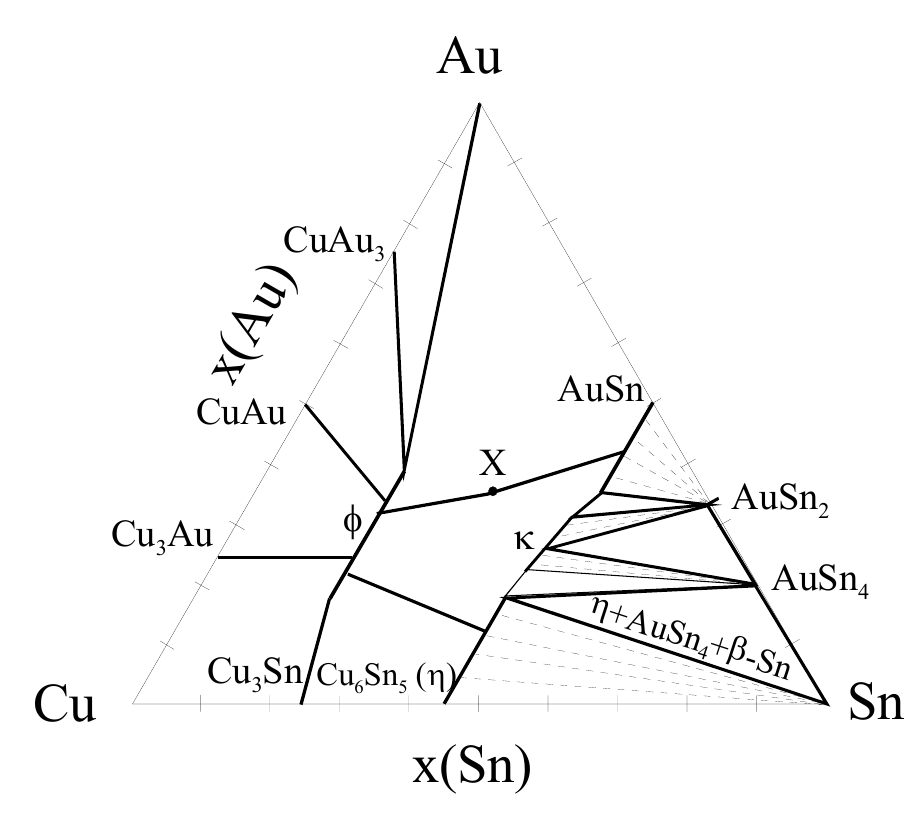
Figure 24. Experimentally determined isothermal section through the Au-Sn-Cu system at 170 °C. Redrawn from